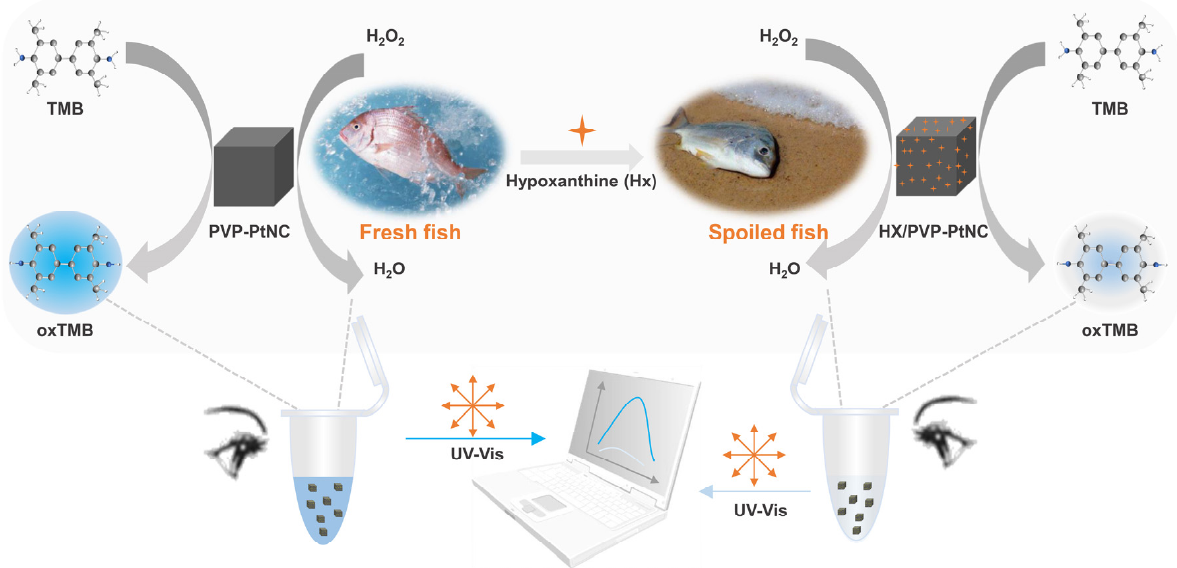
Figure 1. Schematic diagram of the working principle for the PVP-PtNC-based colorimetric detection of Hx.